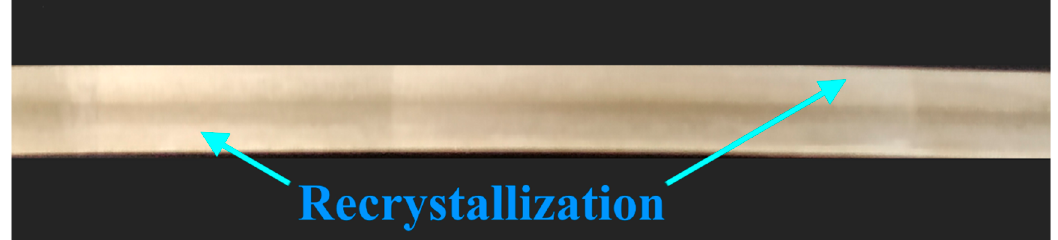
Figure 11. Color change (whitening) of UHMWPE-PE-wax films related to recrystallization process.